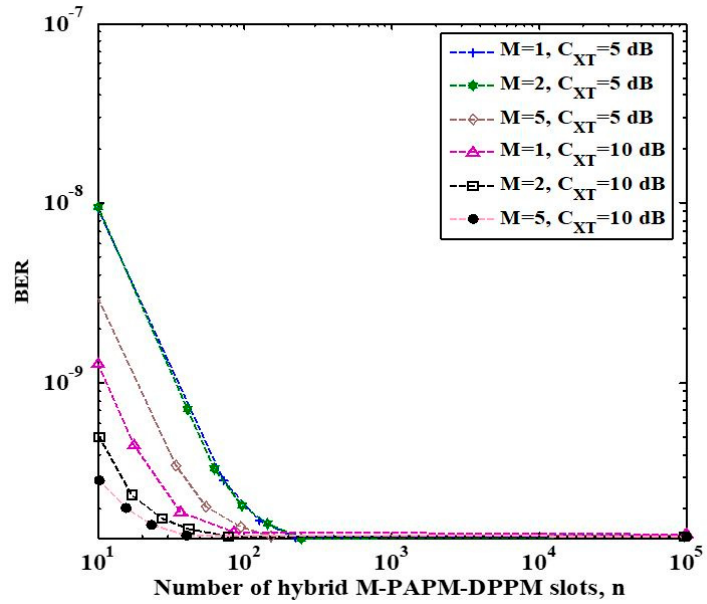
Figure 6. BER vs. the slot numbers ( n ) for the hybrid M-DPPM-M-PAPM using MCB, G = 30 dB.